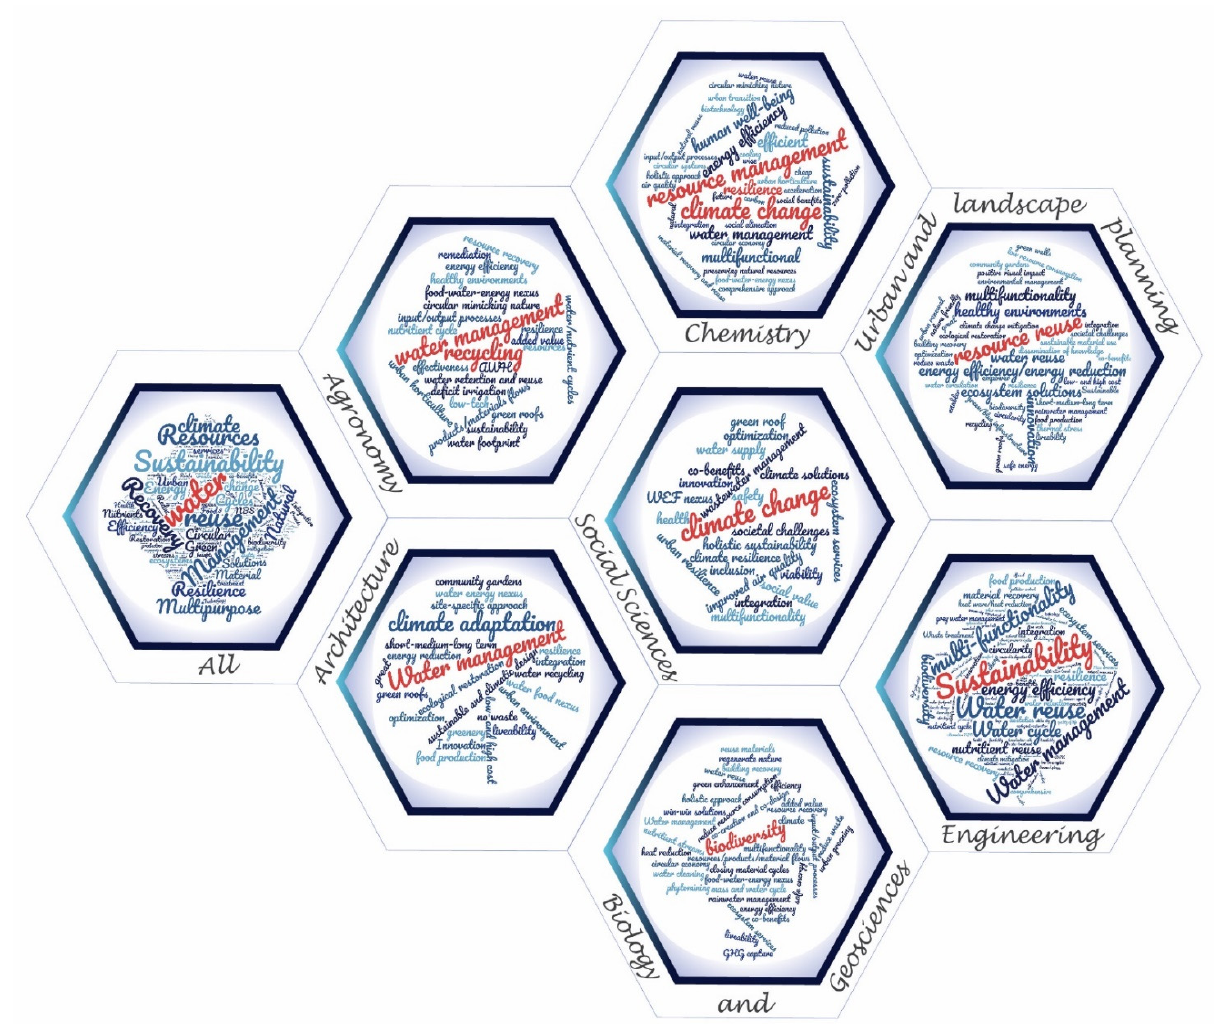
Figure 6. Word cloud of submitted keywords summarizing the potential of NBS to address circularity in cities, based on the reply from all participants (hexagon in the left) and participants with different professional backgrounds.